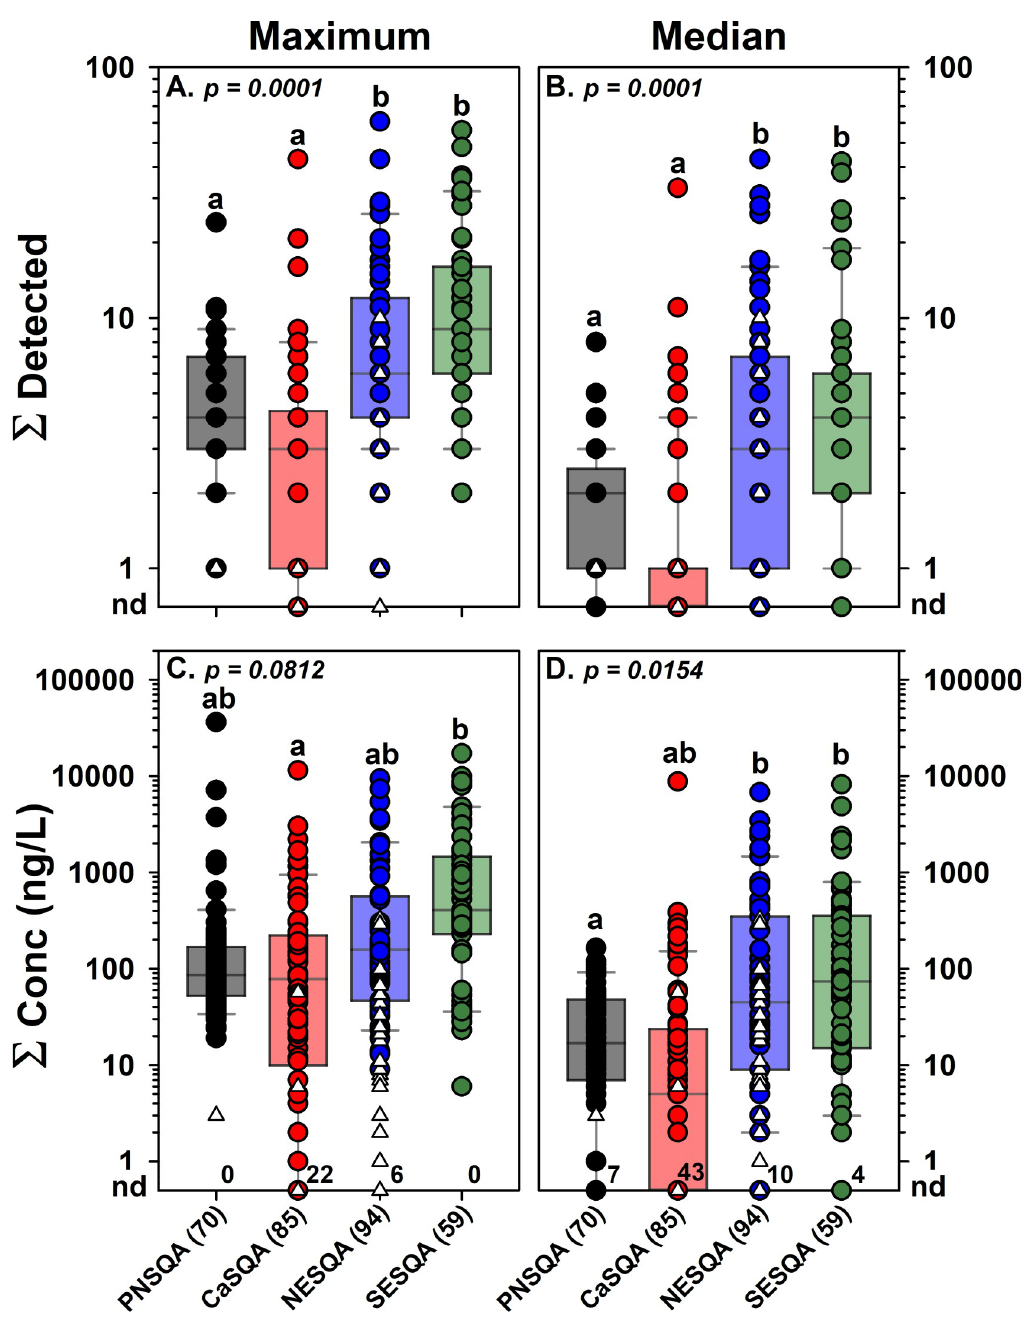
Fig 2. Cumulative maximum (left) and median (right) concentrations (ng/L; bottom) and numbers of pharmaceuticals detected in water samples from wadeable streams in each region (total sites in parentheses) as part of the USGS Regional Stream Quality Assessment (RSQA). Circles indicate maximum (left) or median (right) data for sites sampled multiple times (n = 3–5). Open triangles indicate data from single-sample sites and do not differ between maximum and median plots. Boxes, centerlines, and whiskers indicate interquartile range, median, and 5 th and 95 th percentiles, respectively, for multiple-sample sites (circles), only. For each plot, p is the permuted probability that the centroids and dispersions across all groups are the same and different letters indicate groups with pairwise probabilities that are less than 0.05 (PERMANOVA) for multi-sample sites only. Numbers above X-axes (bottom plots) indicate numbers of sites in each region with no detections (nd) under maximum and median exposure